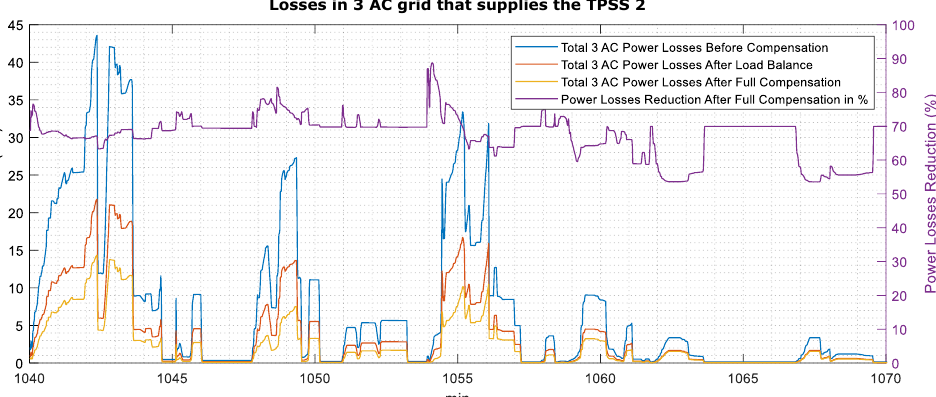
Figure 23. Losses (left axis) and losses reduction (right axis) in the three-phase grid supplying substation #2 in normal mode without and with load balancing.